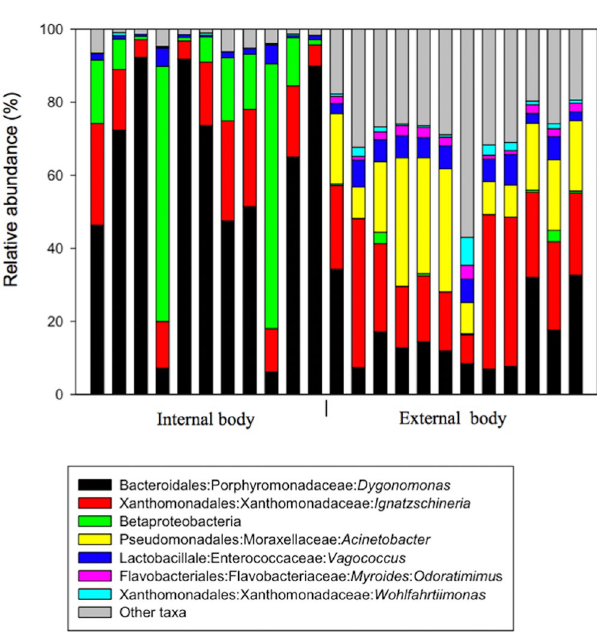
Figure 4. Relative abundance of major bacteria in internal (11 samples) and external body (12 samples) DNA samples from P . regina adults at the highest taxonomic resolution. Bars represent proportions of each taxa. “Other taxa” refers to all the taxa with relative abundance below 1% over the total number of reads. Ten per cent of the reads (10%) of the reads across all samples were classified as Betaproteobacteria. In the legend from left to right: